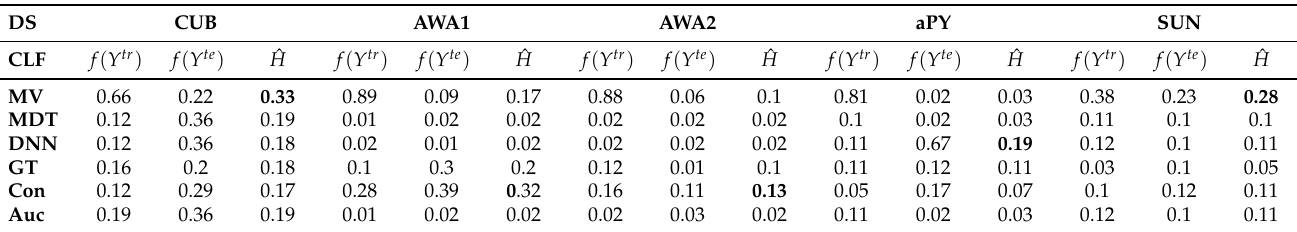
Table 10. Meta-Classifier Results for the F1 Accuracy.